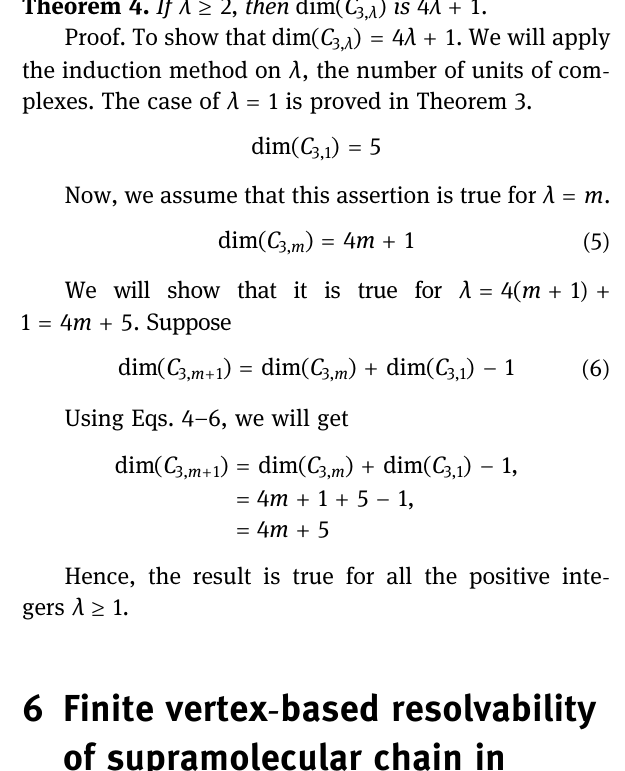
The supramolecular chain in dialkyltin complex - 4 of - valine also has copies of λ units. In N - salicylidene - L Figure 3, similar to complex - 2 and complex - 3, the second unit is connected with the vertices of fi rst unit and simi - larly go on with the copies of λ units. The order of C λ 4, is V C λ 28 λ 4, | ( )| = and the size of C λ 4, is E C λ 31 1. λ 4, | ( )| = − The vertex set and edge set of complex - 4 are given in Figure 3. For more details on this complex network, please the study by Siddiqui et al. ( 2022 )